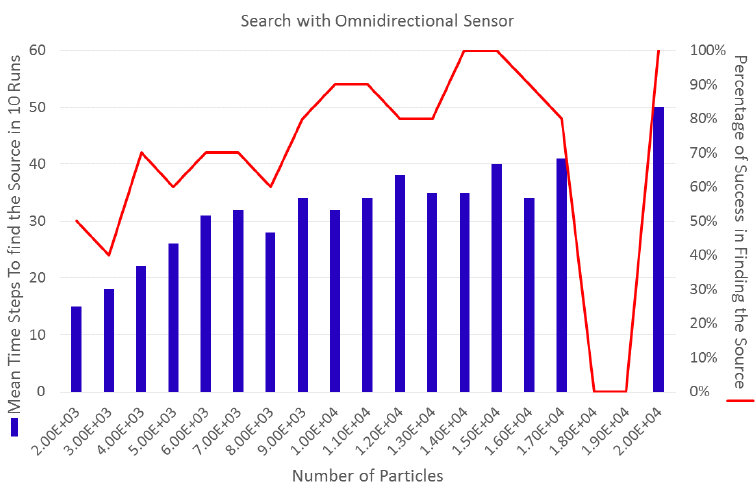
Figure 1. The bar chart shows the mean number of timesteps per 10 trials to localize the plume source in a 200 × 200 unit workspace for a team of 3 robots. The robots start at predefined, randomly chosen, initial state. For each trial, robots start in the same initial state with a randomly generated initial belief distributions. The red line shows the percentage of the time the team successfully located the source for every 10 trials. None of the trials with 1.8 × 10 4 and 1.9 × 10 4 particles succeeded in localizing the